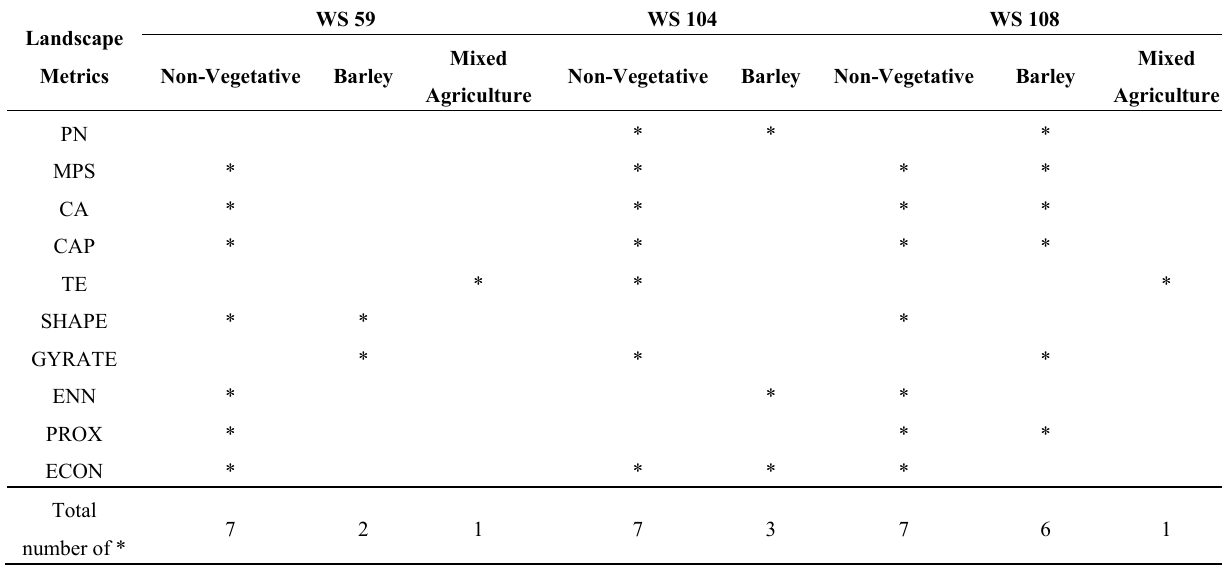
Table 6. Features of candidate rainwater harvesting